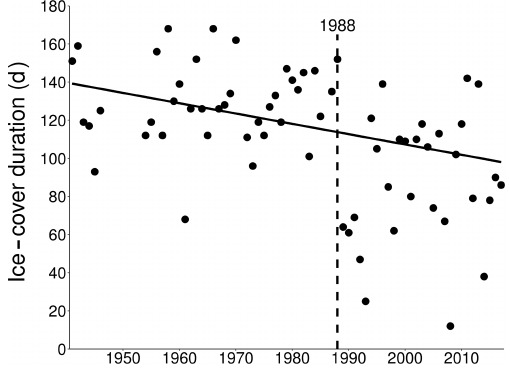
Figure 11. Observed ice-cover duration of Lake Erken between 1941 and 2017 (Sen’s slope: − 7 . 343d per decade, p < 0 . 001). The dashed line shows the year (1988) of abrupt change in ice-cover duration (Pettitt test, p < 0 .